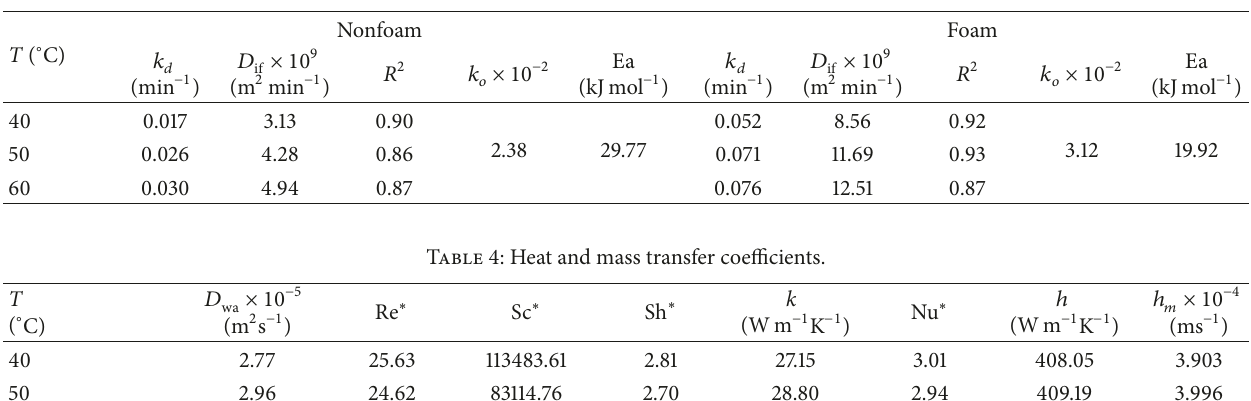
Table 3: The constants of roselle extract drying at different temperature.